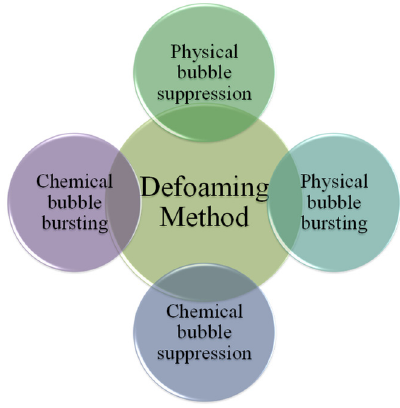
Figure 2. Defoaming methods.